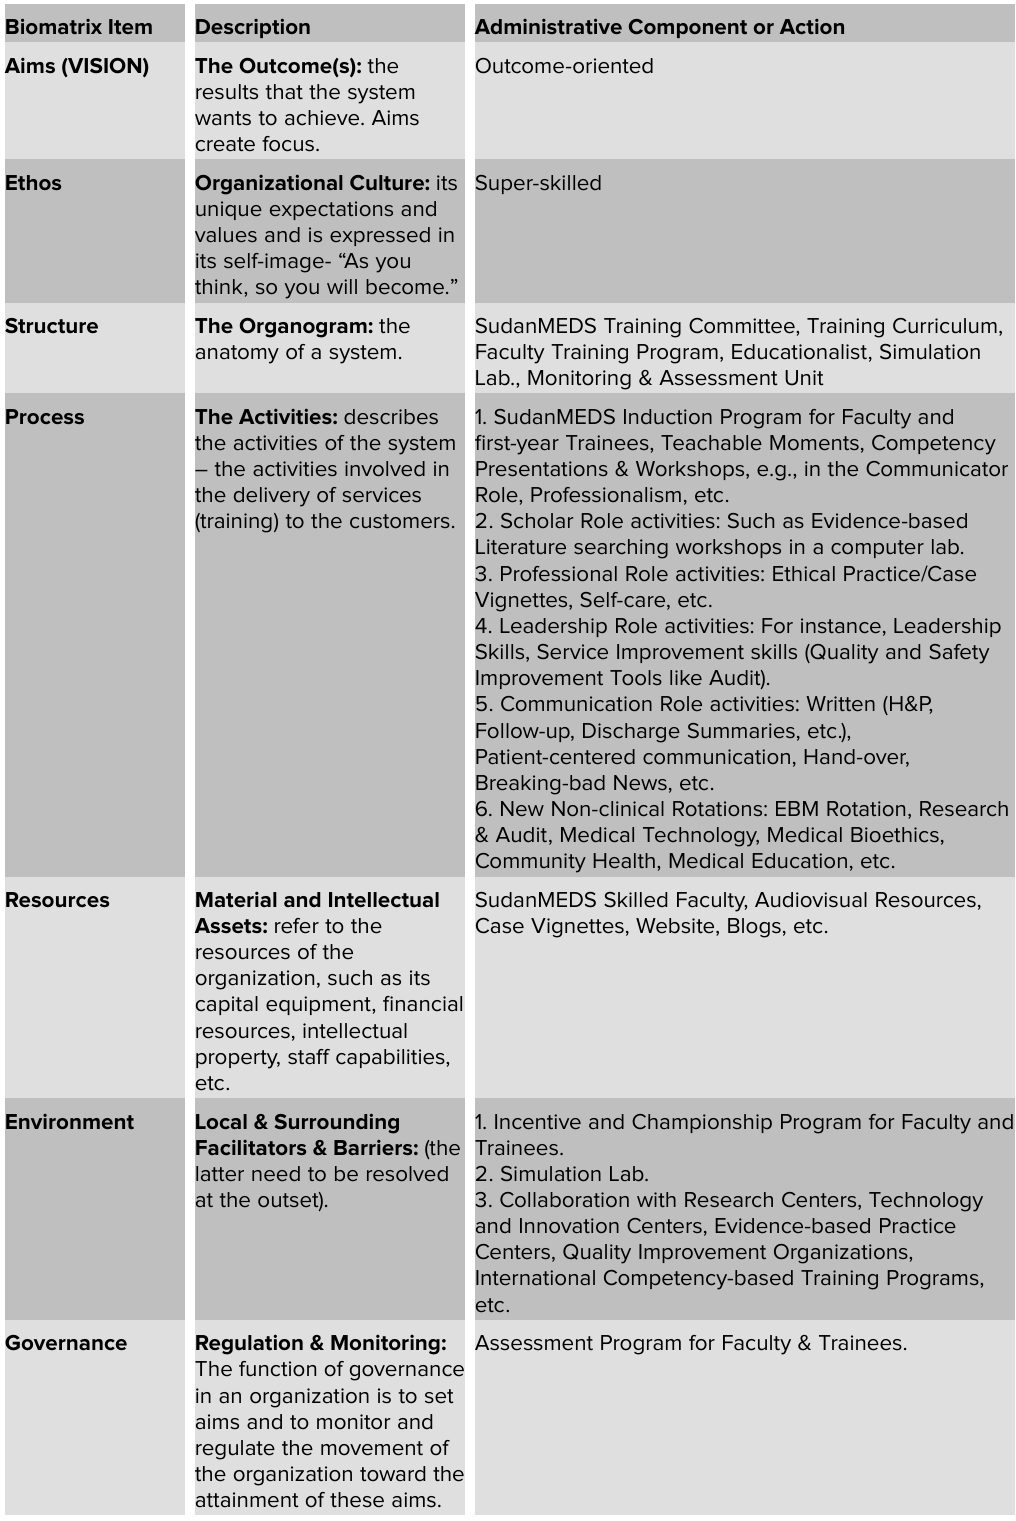
TABLE 1: Proposed SudanMEDS Competency-based Training program Biomatrix elements and